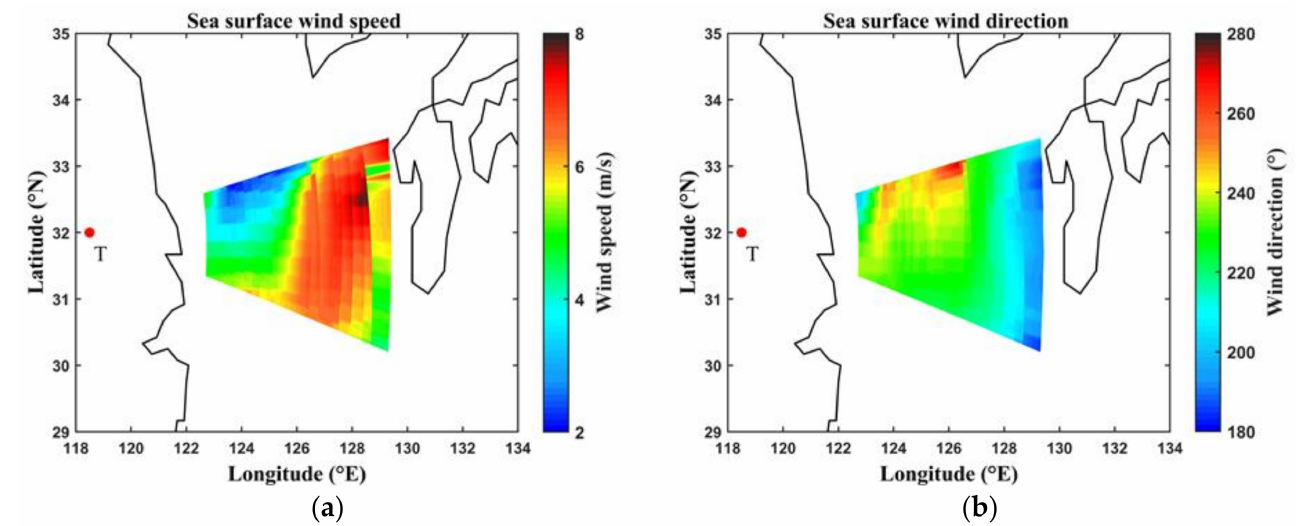
Figure 4. Sea surface wind speed ( a ) and direction ( b ) in the illuminated sea